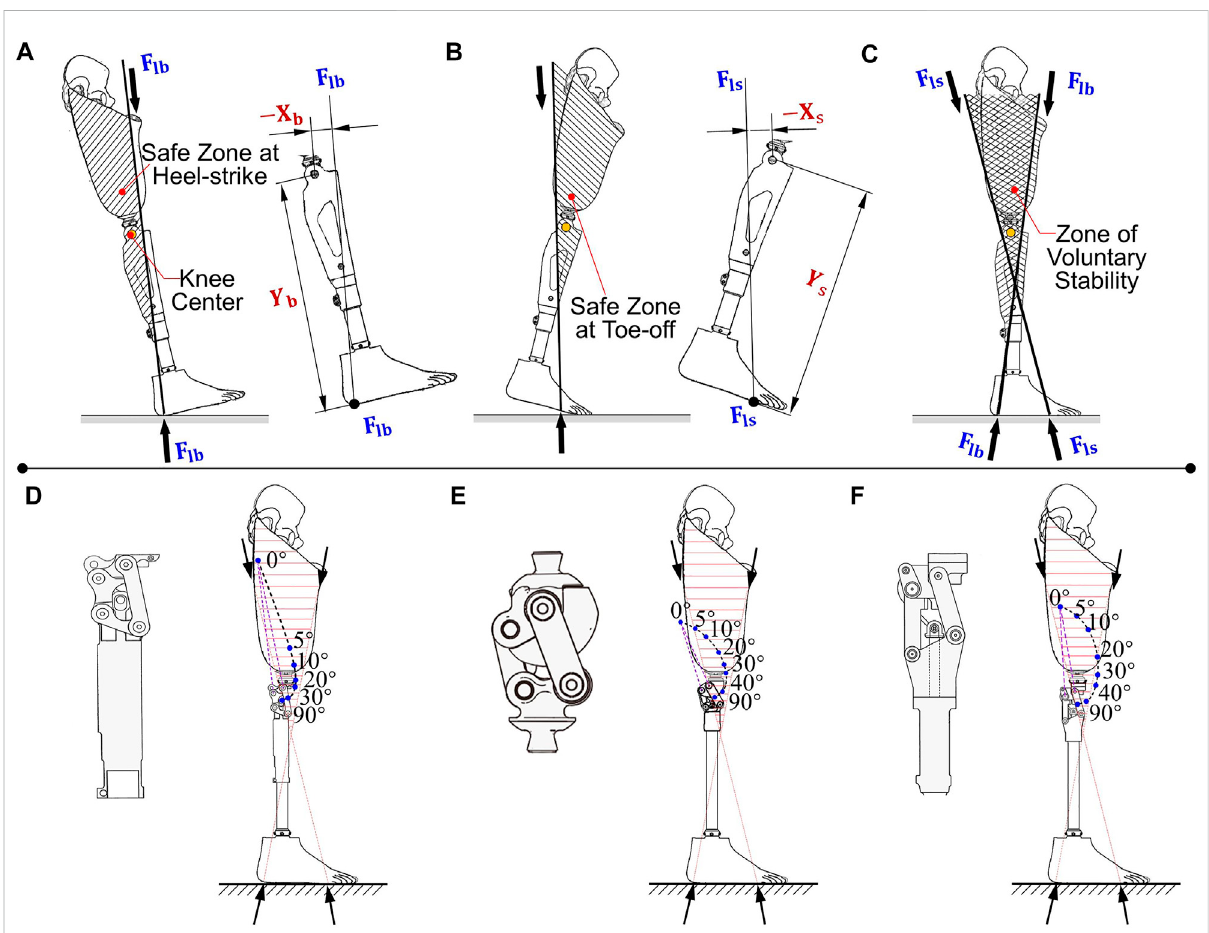
FIGURE 6 Polycentric knees for stance stability. (A) The safe zone at heel-strike based on load line F lb F lb . (B) The safe zone at toe-off based on load line F ls F ls . (C) Thezoneofvoluntarystability,inwhichthekneecanmaintainstabilityatearly-stanceandeaseknee fl exionatpreswing,simultaneously. (D) Polycentric knee with elevated instant center (Proteval ® Acphapend). (E) Hyper-stabilized polycentric knee (Ottobock ® 3R36). (F) Voluntary- controlled polycentric knee (Hosmer ®